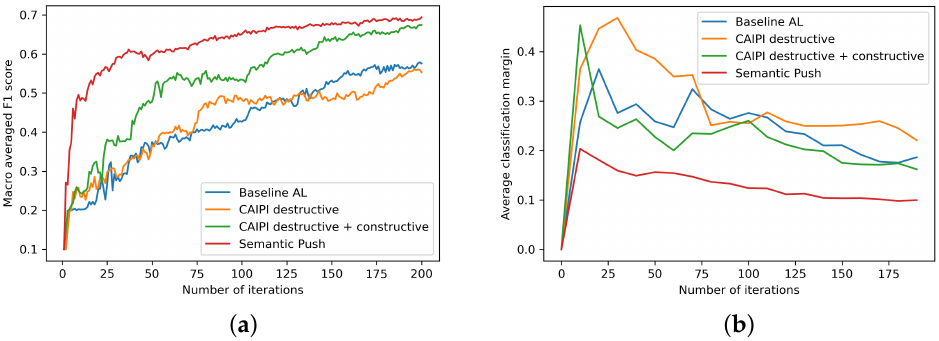
Figure 5. ( a ) Learning performance of different IML strategies for AG News Dataset (XGBoost as base learner). ( b ) Average Classification Margin of different IML strategies for AG News Dataset (XGBoost as base learner).